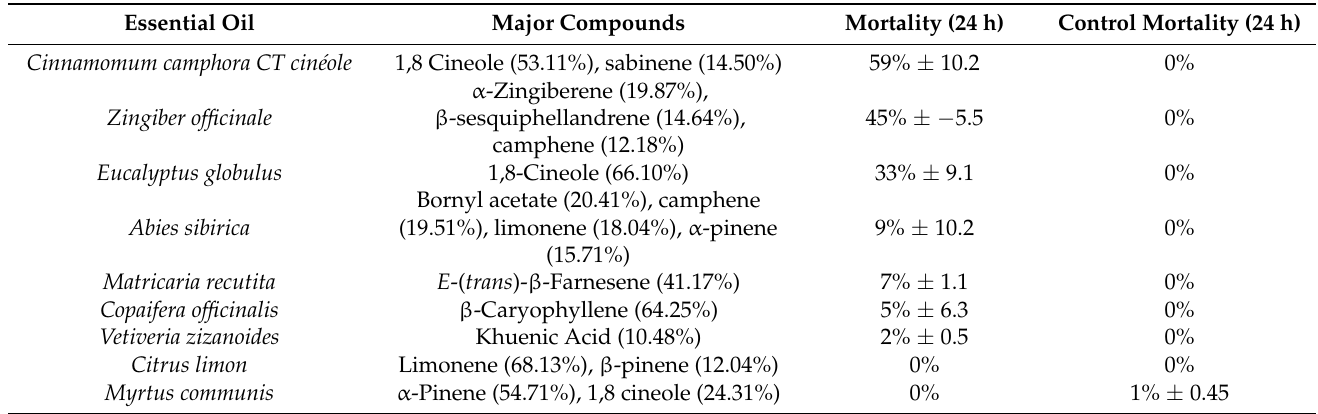
Table 2. Essential oils tested at a concentration of 5% for which the mortality was not